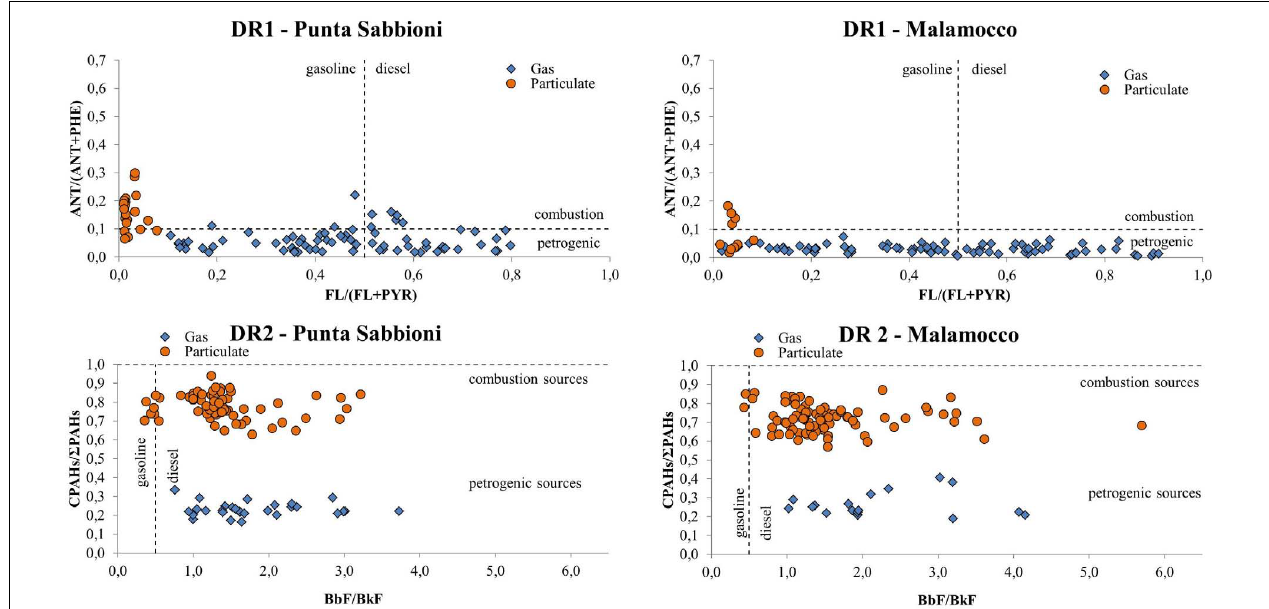
FIGURE 10 | PAH plots of the diagnostic ratios ANT/(ANT + PHE) versus FLA/(FLA + PYR; DR1) and CPAHs/ (cid:54) PAHs versus BbF/BkF (DR2), in Punta Sabbioni and Malamocco